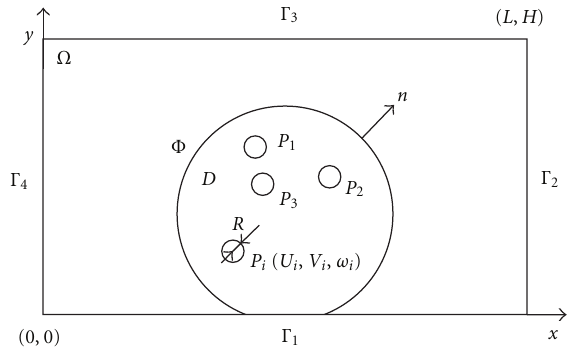
Figure 2: The computational domain with the droplet interface and particles inside in this